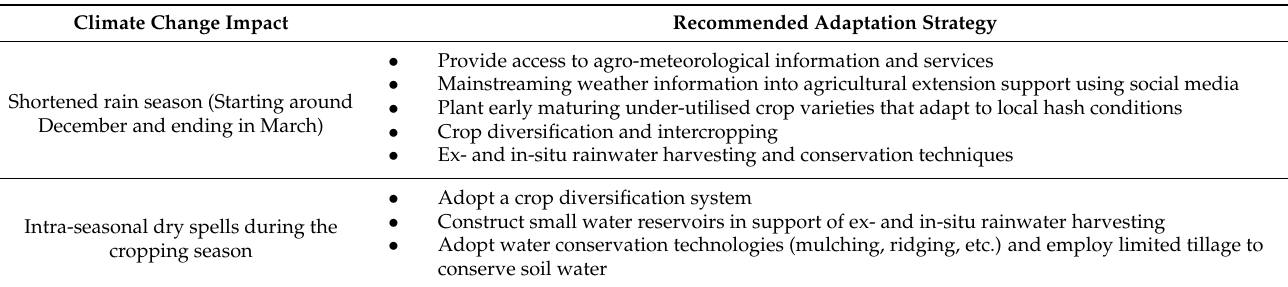
Table 9. Context-based adaptation strategies in Mopani and Vhembe